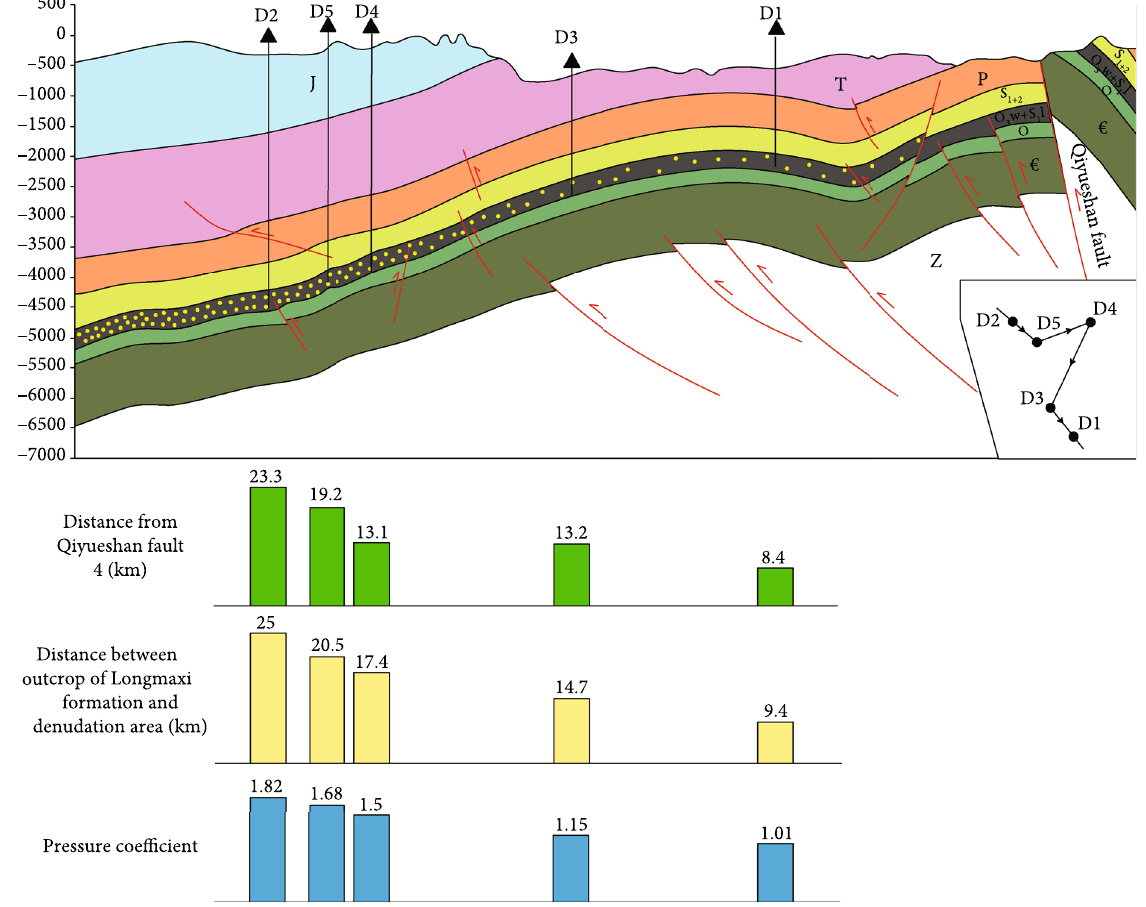
Figure 10: The pro fi le map and formation pressure coe ffi cient of wells D1 to D5 (modi fi ed from Zhu [43]) (Z: Sinian; € : Cambrian; O: Ordovician; S: Silurian; P: Permian; T: Triassic; J: Jurassic). Table 4: Formation pressure and geothermal temperature of Longmaxi shales in Dingshan fi